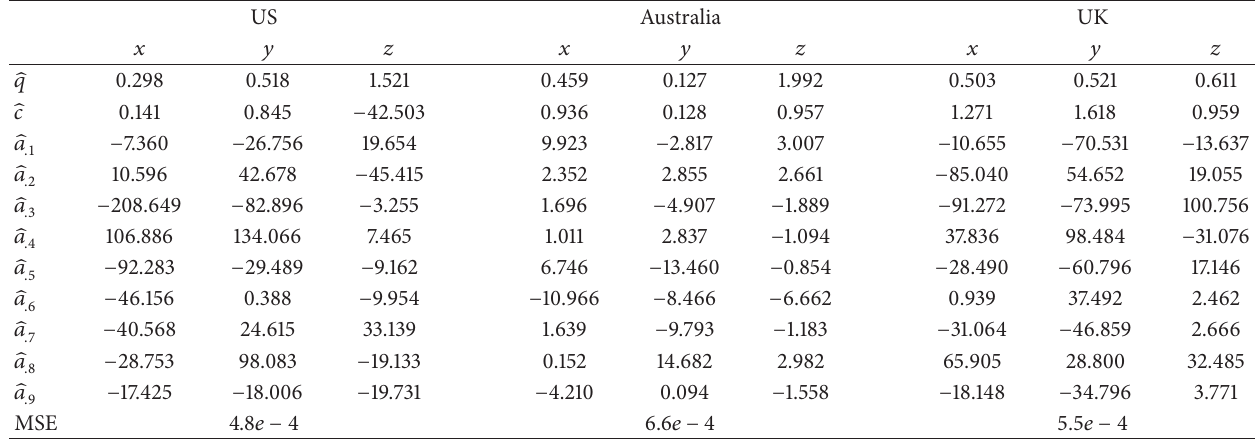
Table 1: Optimal parameters of fractional order economic system for US, Australia, UK.